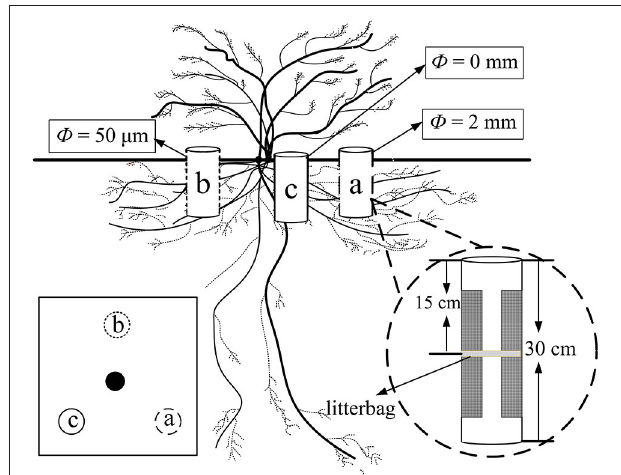
FIGURE 1 | Illustration of PVC ingrowth core installation for the fine root decomposition of Artemisia halodendron under the canopy of an A. halodendron plant. Cores a and b had two windows on each side of the PVC pipe and all faced vertically toward the center of the canopy. There were no windows for core c. The mesh sizes of the nylon mesh for core a and core b were 2mm and 50 µ m, respectively; thus, core a allowed the growth of both fine root and mycelia (R + M), core b only allowed the growth of the mycelia (M), and core c contained only bulk soil (S). This group of ingrowth cores was installed at the point of half canopy width toward the center at an angle of 120 ◦